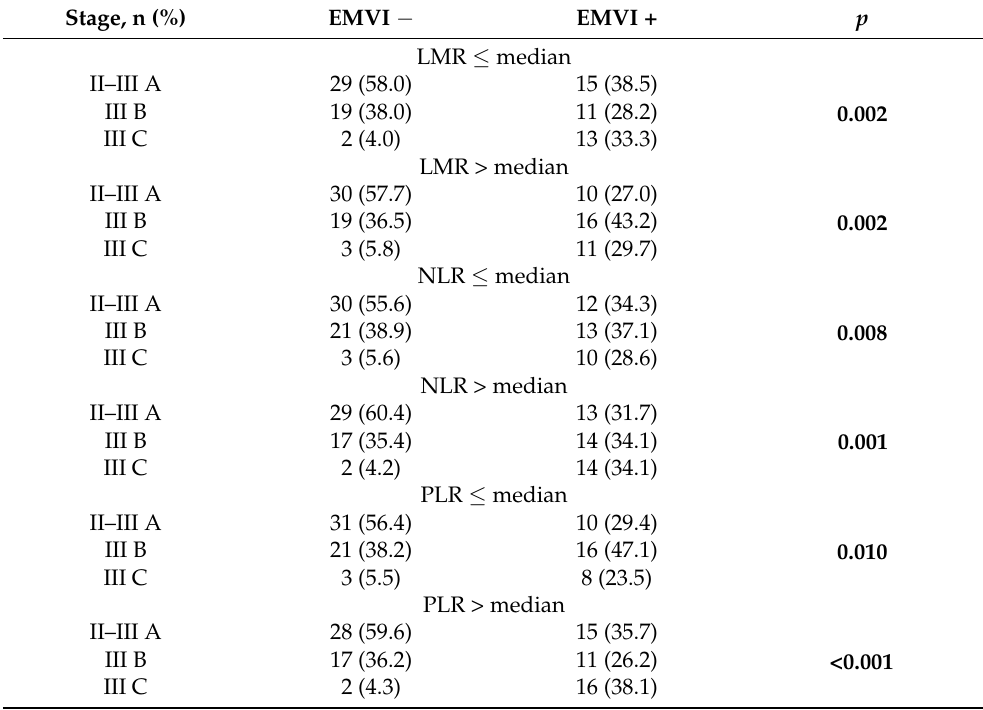
Bold font indicates statistical significance. EMVI, extramural vascular invasion; LMR, lymphocyte-to-monocyte ratio; NLR, neutrophil-to-monocyte ratio; PLR, platelet-to-lymphocyte ratio. Data presented as n (% of EMVI − / EMVI + group). Dependencies were analysed with chi-square test.